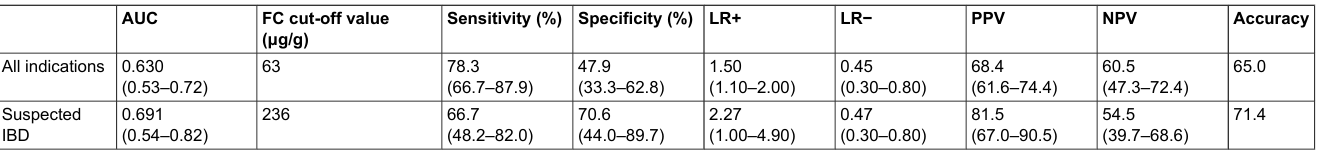
Table 5: The faecal calprotectin test characteristics for identifying small bowel lesions.